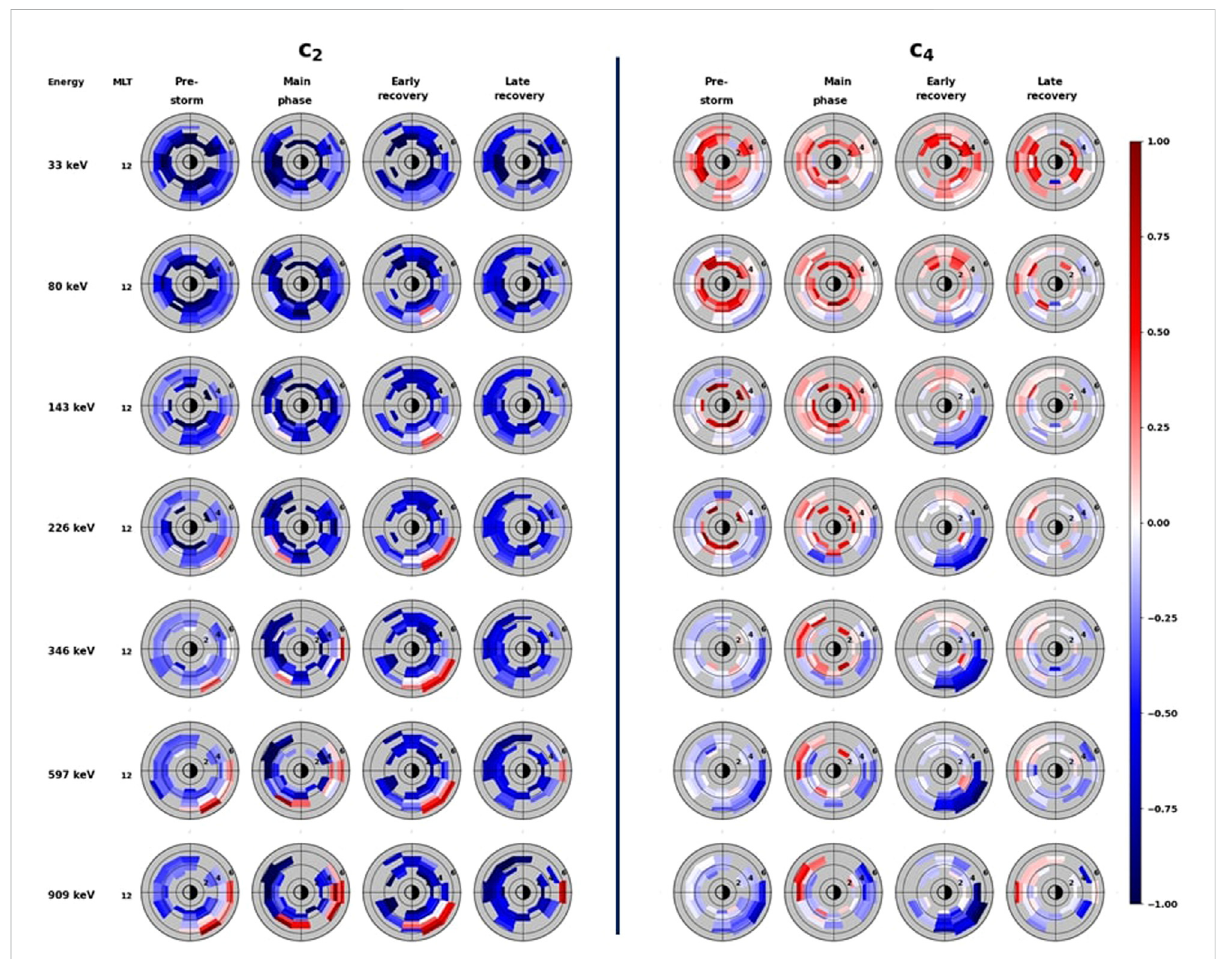
FIGURE 2 The distribution of coef fi cients c 2 (left panel) and c 4 (right panel) in a respective L-MLT bin during coronal mass ejection (CME) driven geomagnetic storms at seven speci fi c energy channels, from top to bottom: 33 keV, 80 keV, 143 keV, 226 keV, 346 keV, 597 keV, and 909 keV. The columns correspond to different storm phases. MLT = 12 isindicated inthe leftmost columnand theconcentriccircles denote Lvalues from L= 1 to 7 with L-width of 2 R E . For each panel, the Earth is at the centre and the Sun is to the left. The colorbar represents the corresponding c 2 and c 4